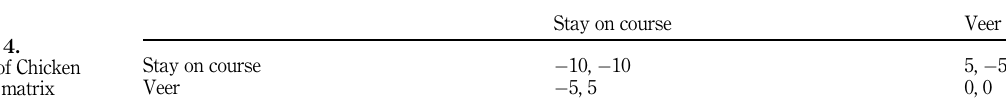
Table 3. Battle of the Sexes payoff matrix